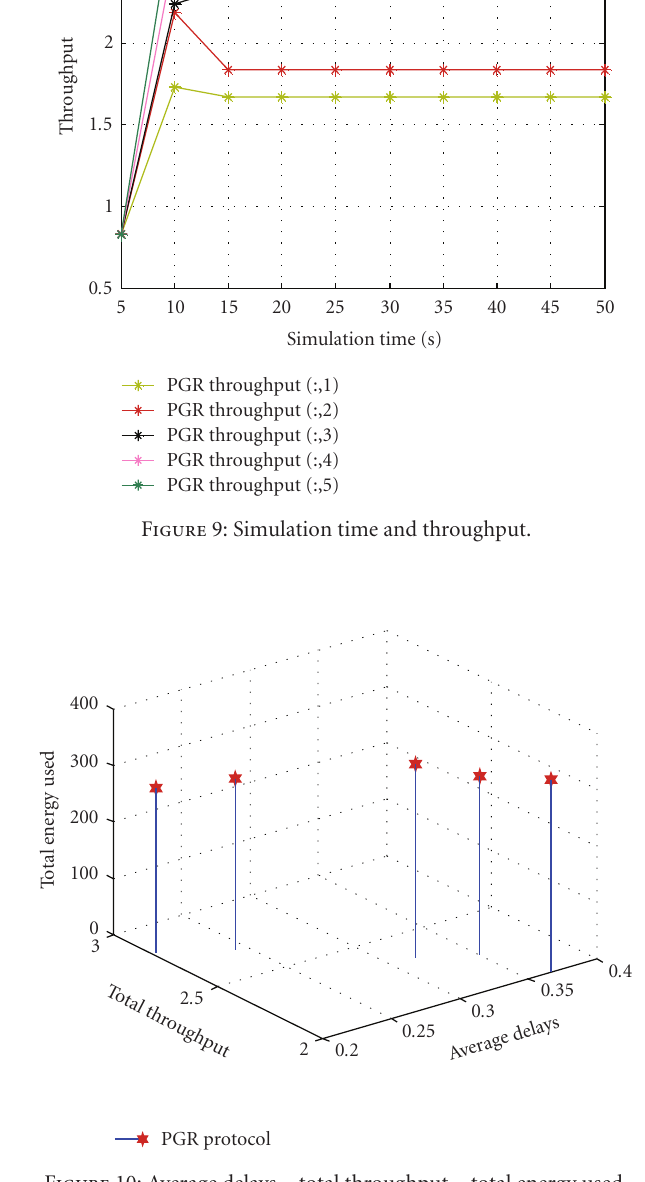
Figure 10: Average delays—total throughput—total energy